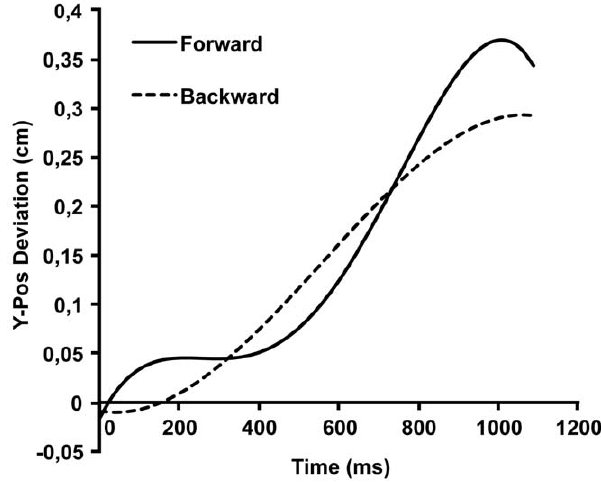
Figure 3. Estimated averaged response curves of y-axis movements from x-axis response onset to response offset in the standing condition. doi:10.1371/journal.pone.0031204.g003 PLoS ONE |